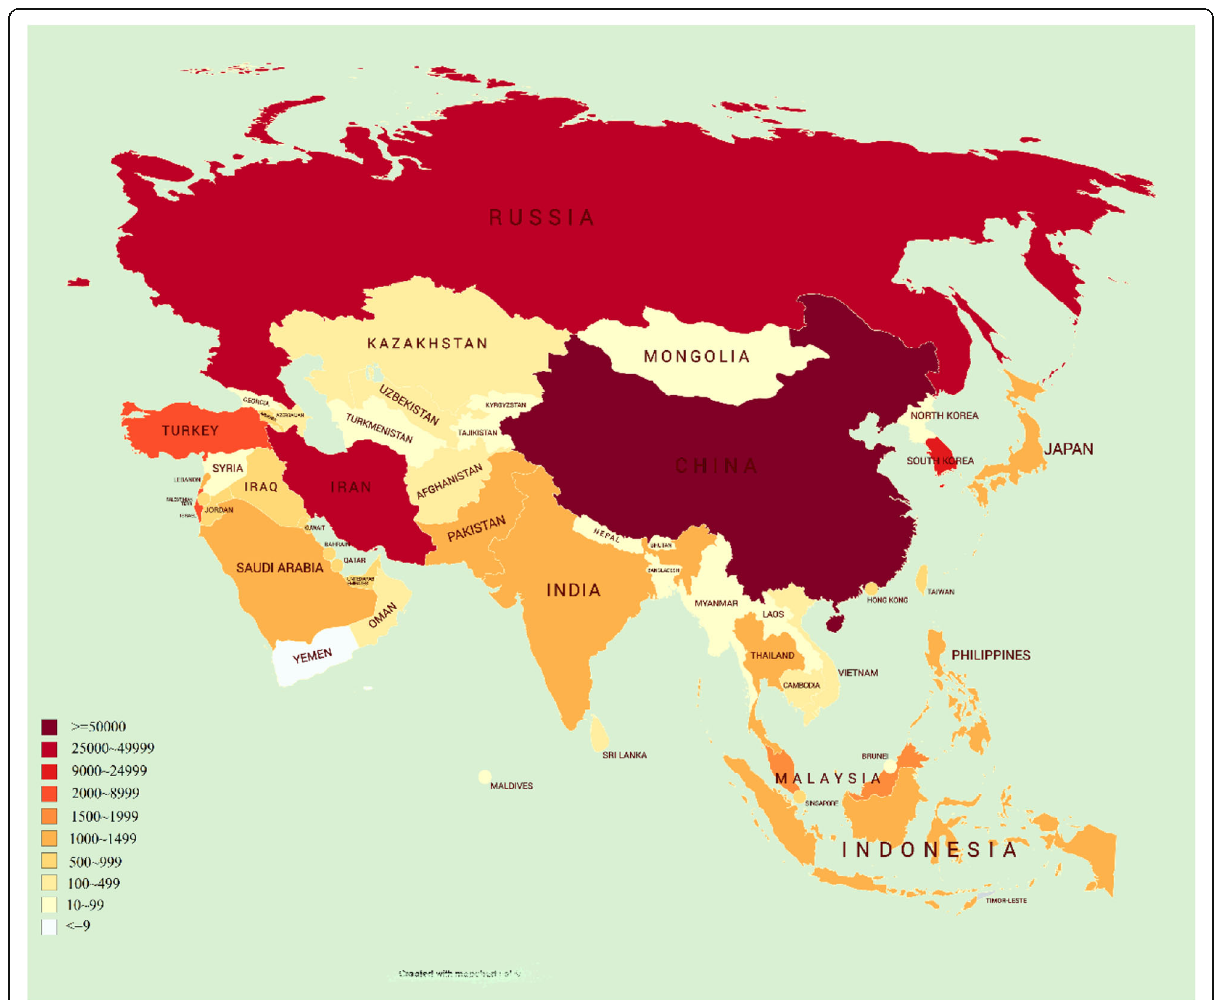
Fig. 1 Asian countries reported confirmed active cases of COVID-19, March 30,